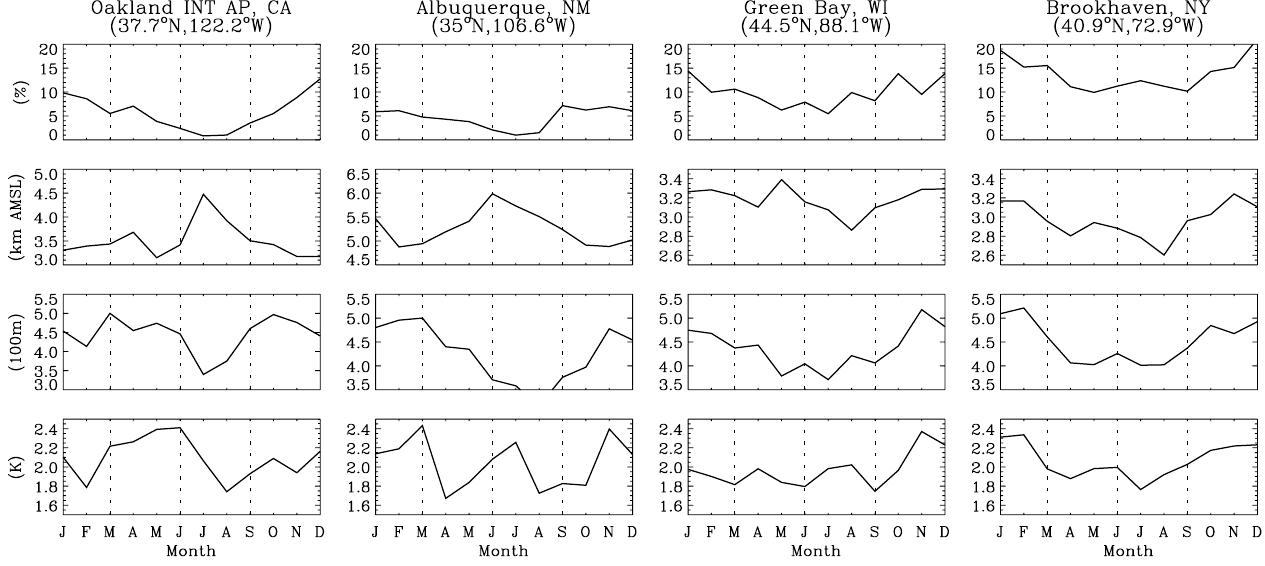
Fig. 5. Averaged monthly variations of the occurrence rate (%), base height (km a.m.s.l.), thickness (100m) and temperature jump (K) for lower tropospheric inversions over 4 stations in 1998–2007.